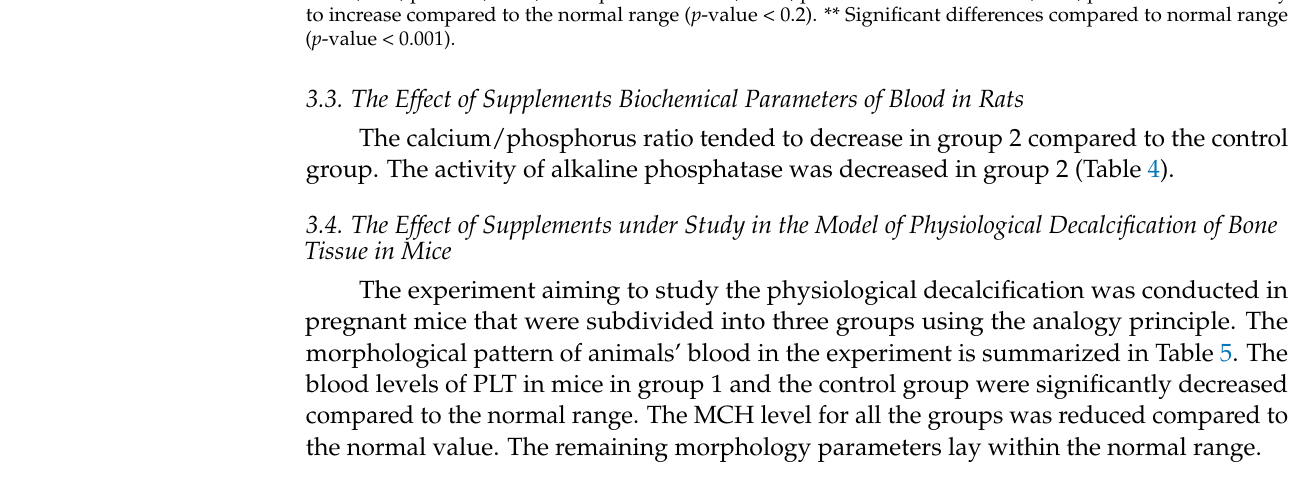
Table 4. Blood biochemistry parameters for serum samples of rats receiving feed supplements containing chelated silicon and vitamin D after the experimentally induced mechanical damage to the femoral